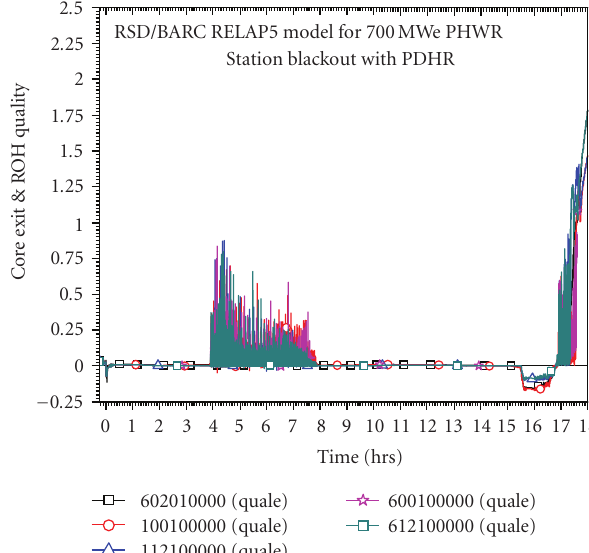
Figure 12: PHT pressure variation case-no delay in valving in PDHRS.